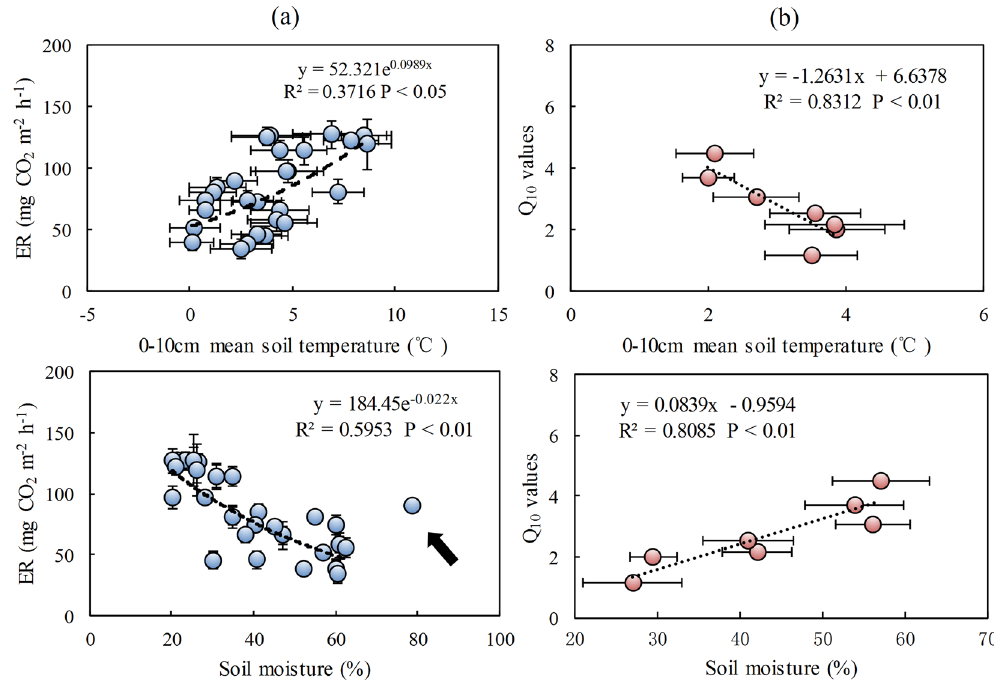
Figure 3. Panel (a) Relationship between ER and 0–10 cm mean soil temperature, soil moisture at the tundra sites. ( b ) Correlations between tundra Q 10 values and soil temperatures, soil moisture. The arrow indicates outlier data, which are excluded from the correlation. Note: the figures for Q 10 fitting at each site were given in Supplementary Material.